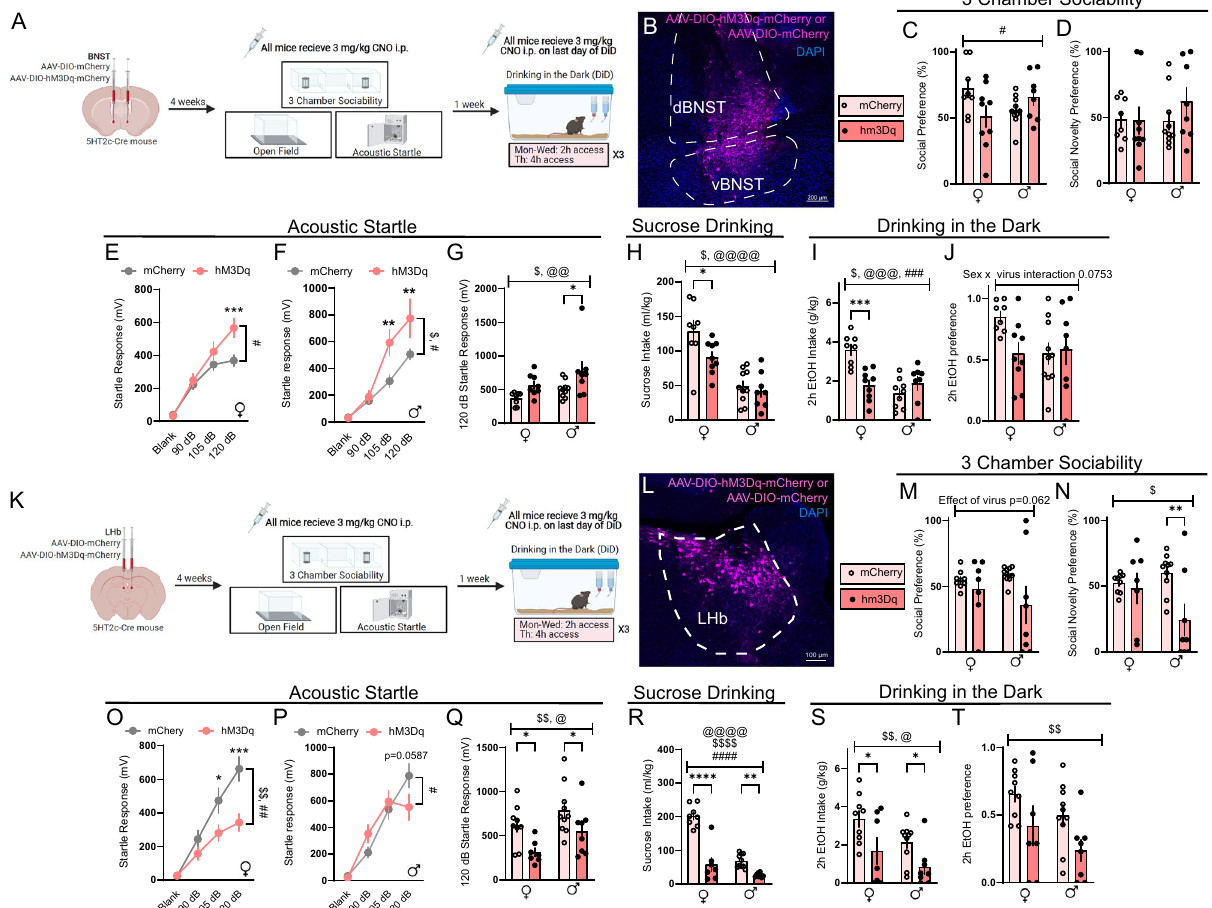
Fig. 4 | Chemogenetic activation of LHb 5HT2c or BNST 5HT2c neurons modulates affective behaviors and binge alcohol consumption. A Surgical schematic and experimental timeline for BNST 5HT2c chemogenetic activation experiments. B Representative viral infection in BNST. Similar viral infection was reproduced in n =35mice. C Socialpreferenceinthe3-chambersociabilitytest, p virusXsex =0.0192. D Social novelty preference in the 3-chamber sociability test. E Acoustic startle behavior in females (10trials/dB), two-wayrepeated-measuresANOVAfollowed by Holm-Sidak ’ s post-hoc, p virus =0.0814, p virusXdB =0.0105. 3. F Acoustic startle behavior in males (10 trials/dB), two-way repeated measures ANOVA followed by Holm-Sidak ’ s post-hoc, p virus =0.0246, p virusXdB =0.0111. G Acoustic startle beha- vior 120dB only (10 trials), p virus =0.0058, p sex =0.037. H Sucrose consumption, p p p virus =0.0387, sex =0.0001. I 2h Alcohol intake in DiD, virus =0.0303, p p sex =0.0007, sexXvirus =0.0003. J 2h Alcohol preference in DiD. K Surgical sche- matic and experimental timeline for LHb 5HT2c chemogenetic activation experi- ments. L Representative viral infection in the LHb. Similar viral infection was reproduced in n =31 mice. M Social preference in the 3-chamber sociability test. N Social novelty preference in the 3-chamber sociability test, p virus